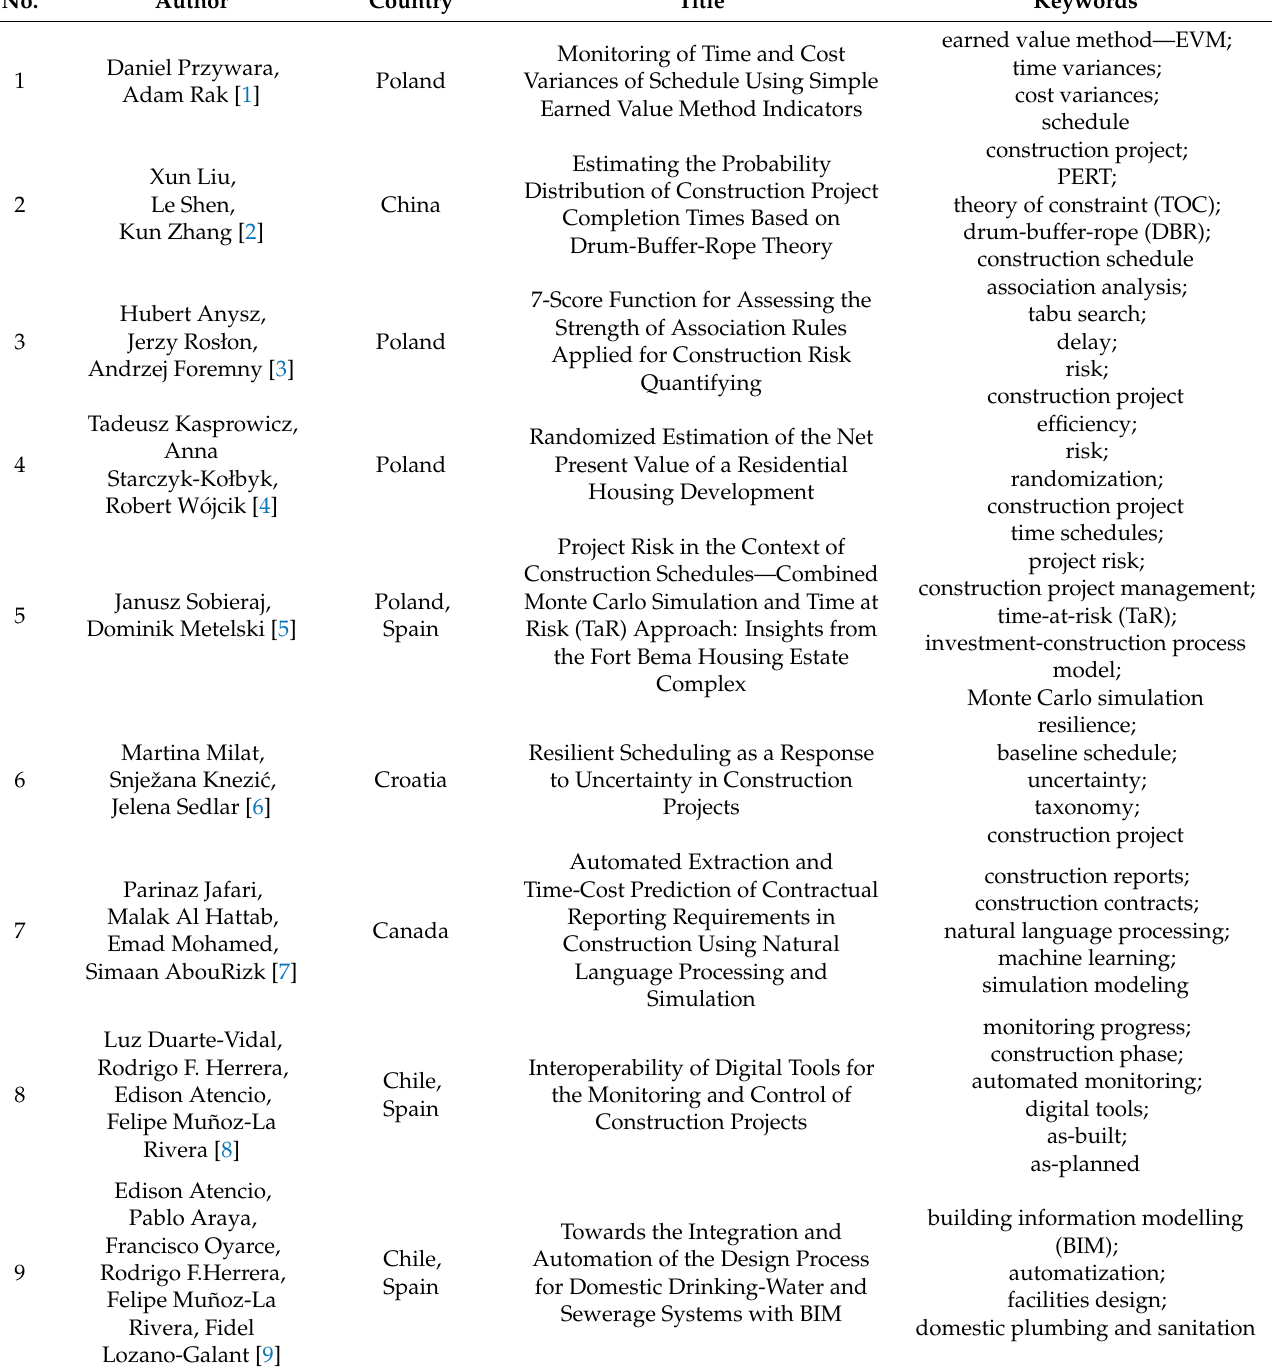
Table 1. The content of the Special Issue “Technology and Management Applied in Construction Engineering